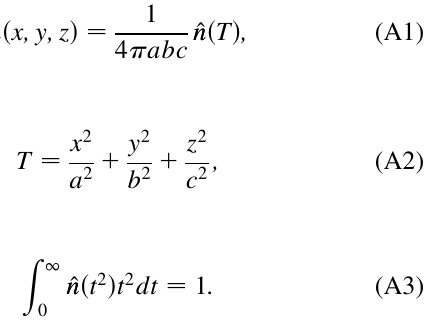
FIG. 11. (Color) 3D simulation emittance evolution for Q 6 : 29 comparing analytical fully ‘‘frozen’’ space charge with results obtained by using a continuously updated rms size (squares: measured values).